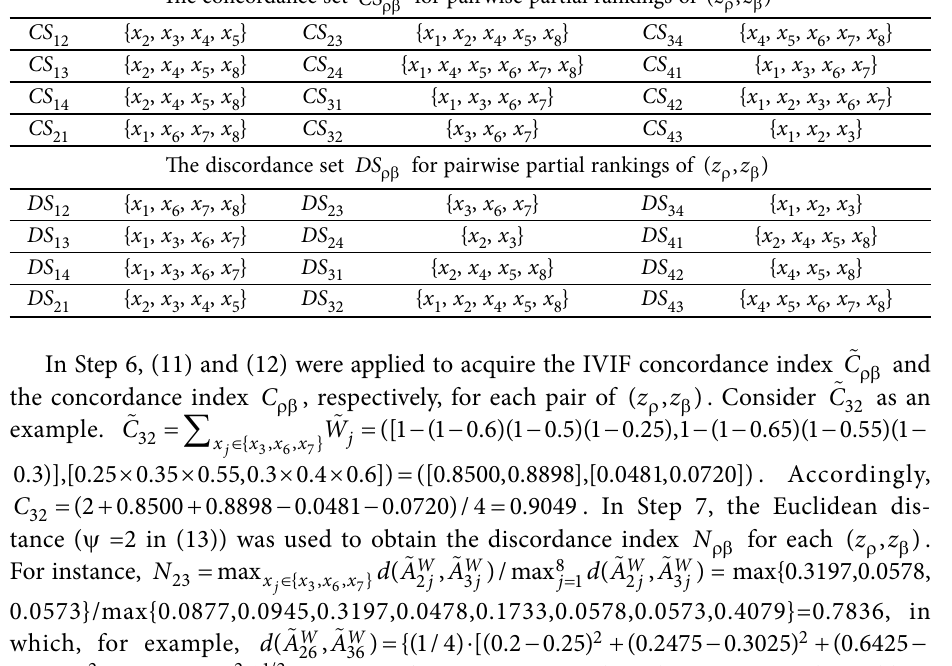
Table 6. Results for the concordance and discordance sets The concordance set ρβ CS for pairwise partial rankings of